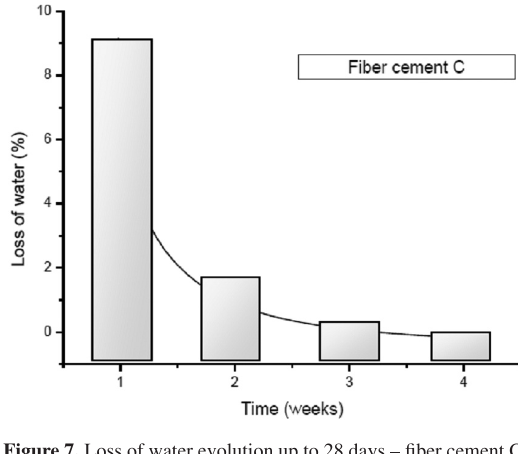
Figure 7. Loss of water evolution up to 28 days – fiber cement C.